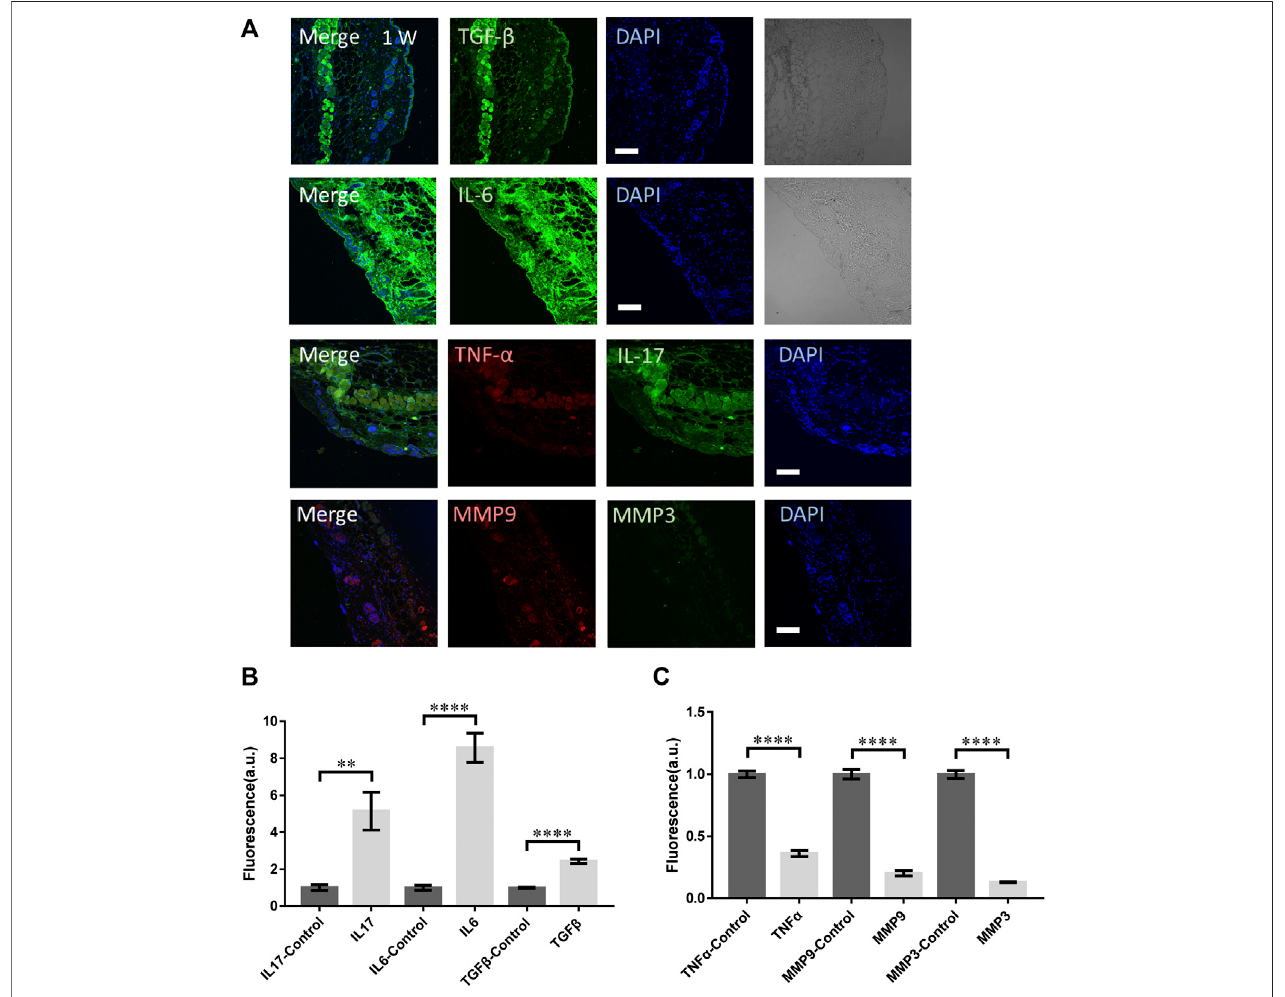
FIGURE4| Themolecularresponsesofskintotheunfocusedlaserirradiationat1W. (A) Theimmuno fl uorescenceimagesand (B,C) thestatisticalanalysisofthelaser- treated samples and control respectively. n (cid:1) 6 samples from three independent trails. Bar: 100 μ m. * p < 0.05. ** p < 0.01. *** p < 0.001. **** p < 0.0001, by students ’ t-test.